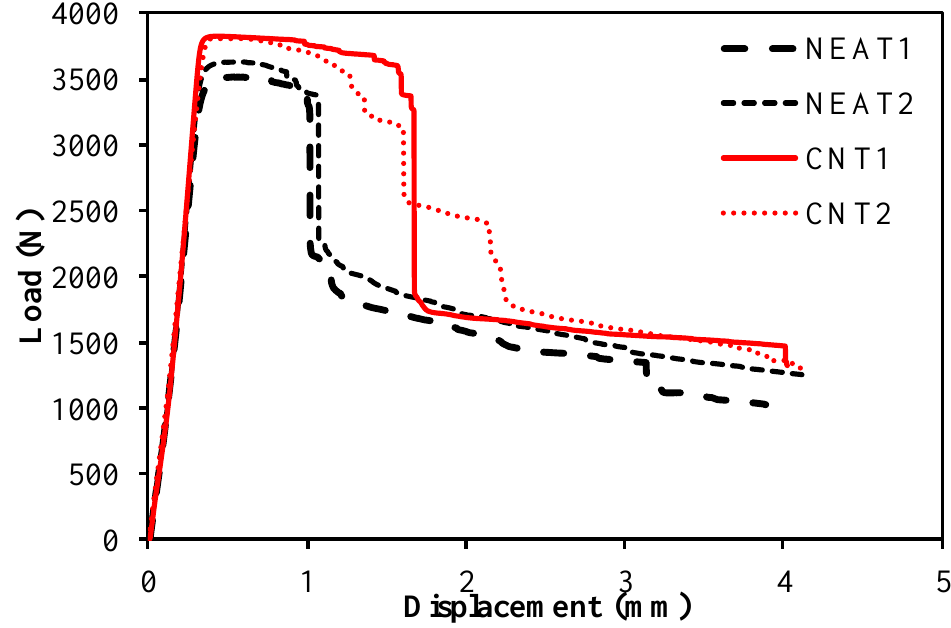
Figure 9. Buckling test results of the samples with clamped – clamped.